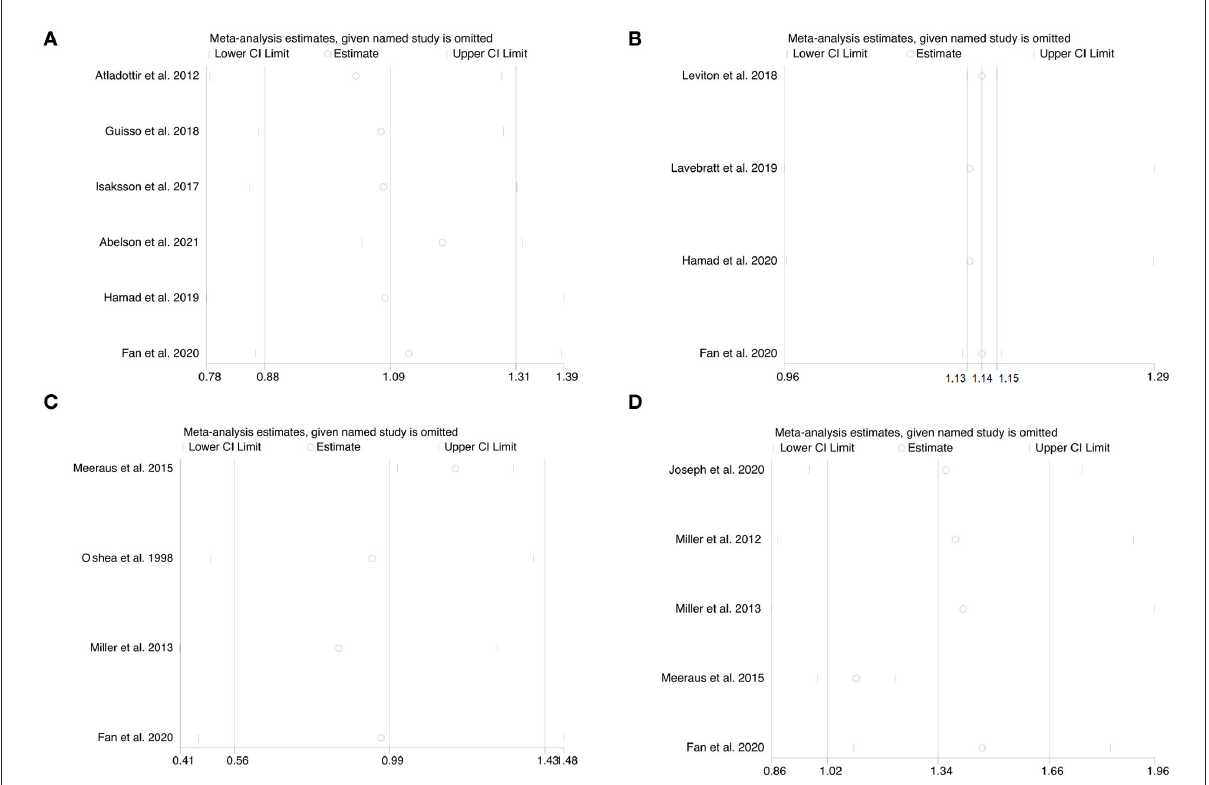
FIGURE4 (A–D) Sensitivity analysis for the association of prenatal exposure to antibiotics and risk of neurodevelopmental disorders in the offspring. (A) Risk of ASD. (B) Risk of ADHD. (C) Risk of CP. (D) Risk of